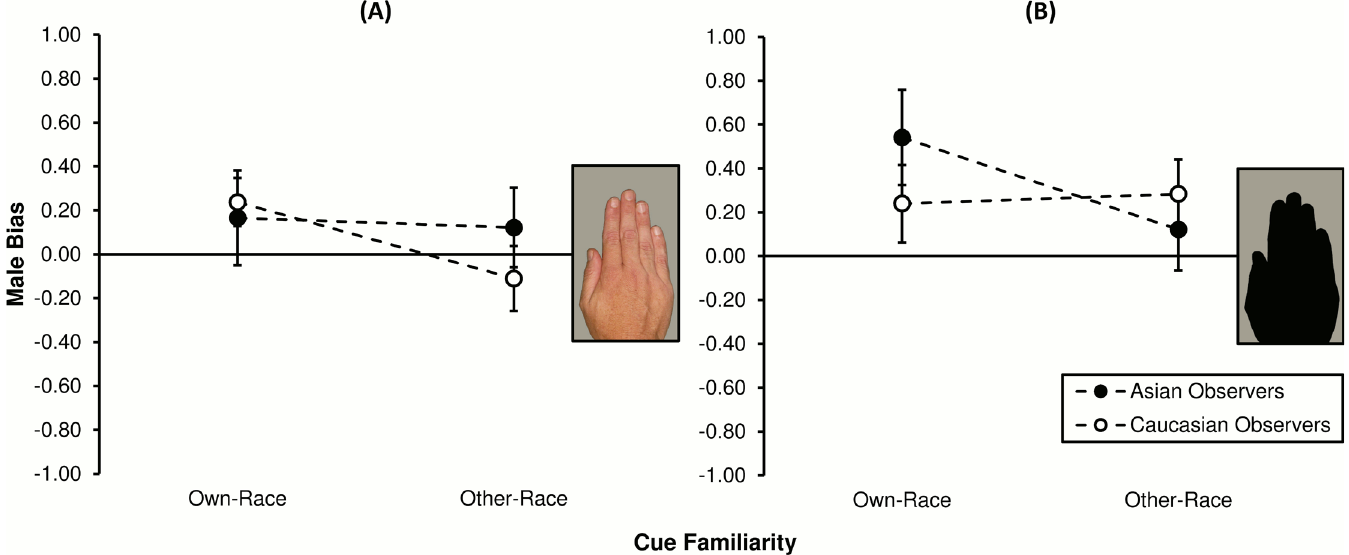
Fig 4. Sex classification bias for observers of hands each presented for 1000 ms. Values on the ordinate represent, in standard units, difference between female target and male target criteria means ( c A : see Methods). Scores are grouped by observer race (Asians or Caucasians) and cue familiarity (own-race or other-race hands), plotted separately for the ( A ) intact and ( B ) degraded visual cue condition. Vertical bars represent ± 1 SEM .